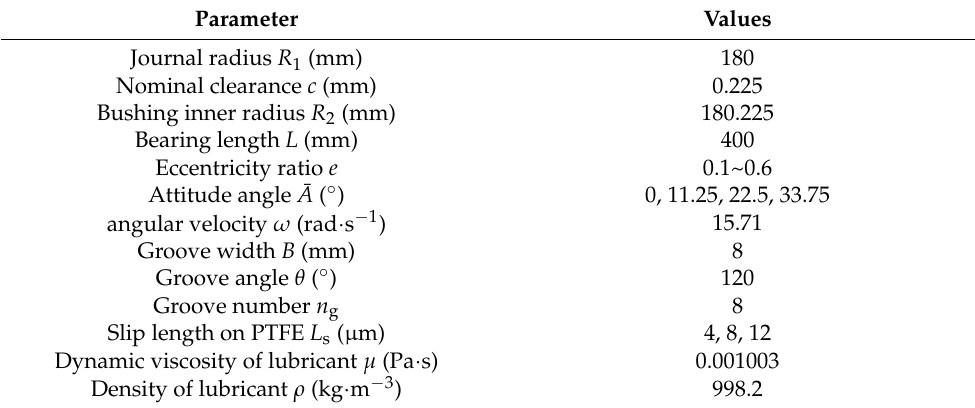
Table 1. Parameters of water-lubricated hydrodynamic journal